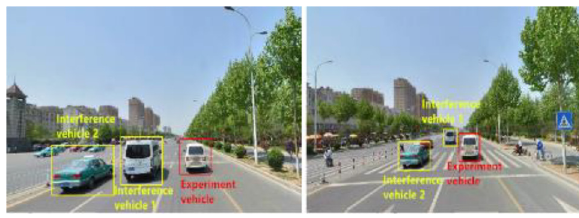
Figure 4 Screenshots of the experimental scenes (in Xincun West Road)